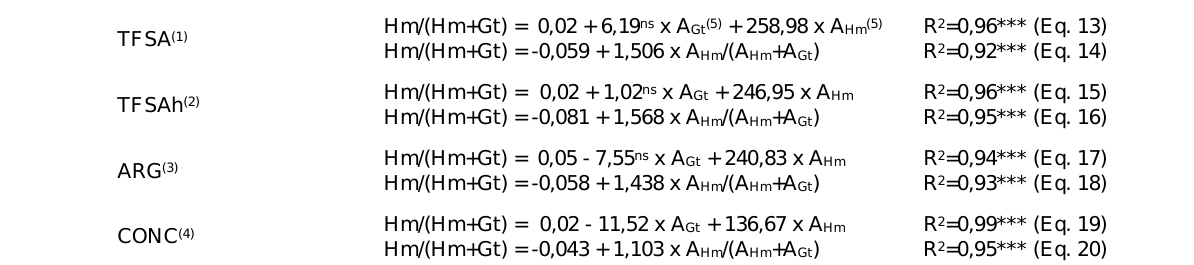
(1) Terra fina seca ao ar. (2) Terra fina tratada para a eliminação da matéria orgânica. (3) Fração argila. (4) Argila concentrada em óxidos de ferro. Todos os coeficientes das equações de regressão foram significativos a 0,1 %, à exceção dos indicados. (5) A amplitudes das banda atribuídas à hematita e goethita, respectivamente (conforme Figura